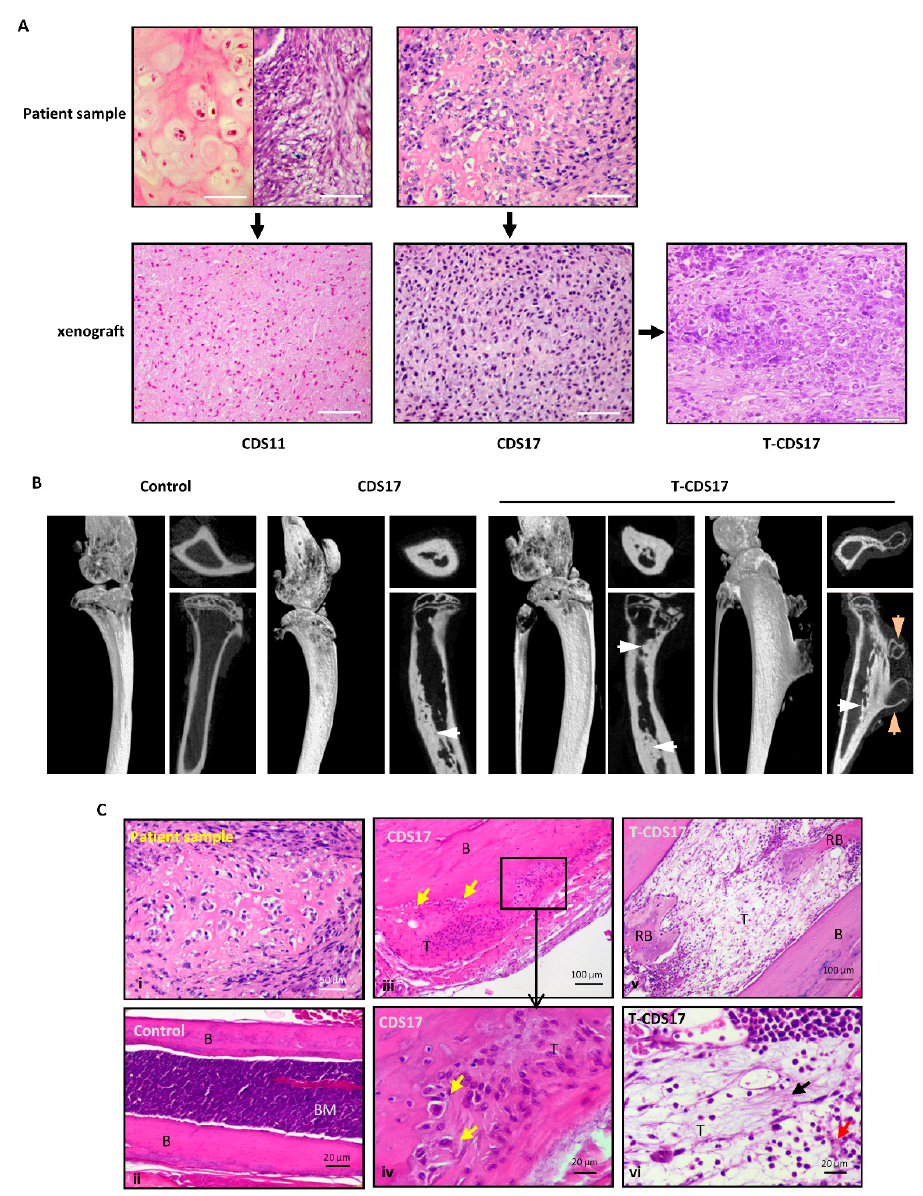
Figure 1. In vivo tumorigenicty of chondrosarcoma cell lines. ( A ) Histological analysis (H&E staining) of original patient tumors and tumors developed 1 month after subcutaneous (s.c.) inoculation of CDS11, CDS17, and T-CDS17 cell lines in immunodeficient mice. Two different areas of the CDS11 patient tumor sample are shown. scale bars = 150 µm. ( B ) Radiologic examination (µCT scan) of tumors developed after intra-bone (i.b.) inoculation of CDS17 and T-CDS17 cells in immunodeficient mice. Coronal, sagittal and axial images are shown. Compared to a control leg, intra-medullar formation of tumor bone/osteoid formation (white arrows) is shown in mice inoculated with both cell lines. In addition, a mouse inoculated with T-CDS17 cells presented an extra-medullar lesion compatible with the radiographic features of osteochondrosarcoma (orange arrows). ( C ) H&E staining of an original patient sample (i), a control leg (ii), and tumors formed after i.b. inoculation of CDS17 (iii and iv) and T-CDS17 (v and vi) cells lines. Chondroid.like cells (yellow arrows) and areas of fibrillar (black arrow) and amorphous (orange arrow) osteo-chondroid matrix are indicated. (B: bone; RB: reactive bone).